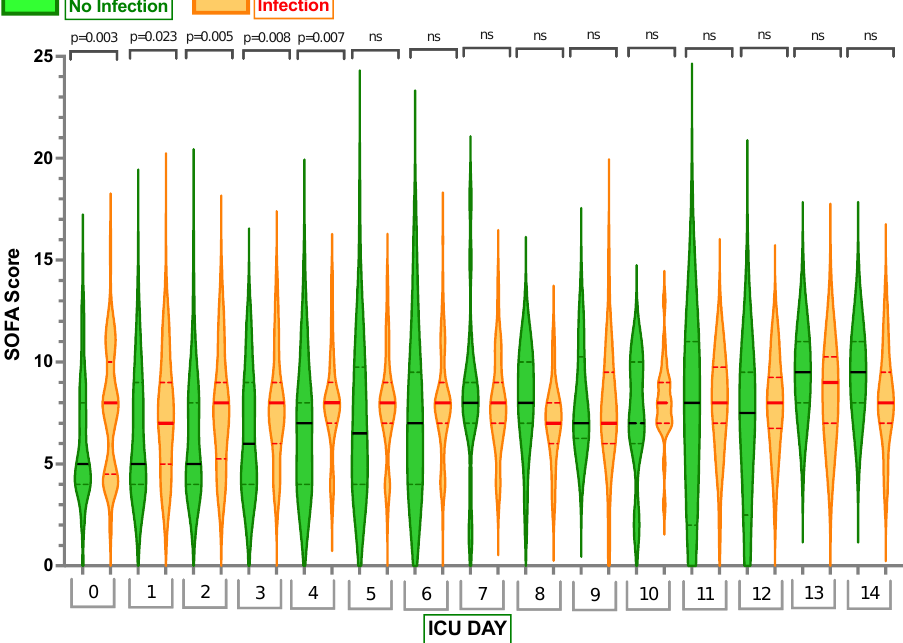
Figure 5. Comparison of Sequential Organ Failure Assessment (SOFA) scores in Infection Group and No Infection Group. Violin plots represent the distribution of data. Hard lines show medians, and dashed lines show interquartile ranges. The y-axis represents SOFA Scores in Days. The x-axis represents Days in the Intensive Care Unit (ICU) with 0—SOFA Score Day 0. ns—no statistically significant difference from the Independent Mann–Whitney U test. p < 0.05 indicates statistical significance.